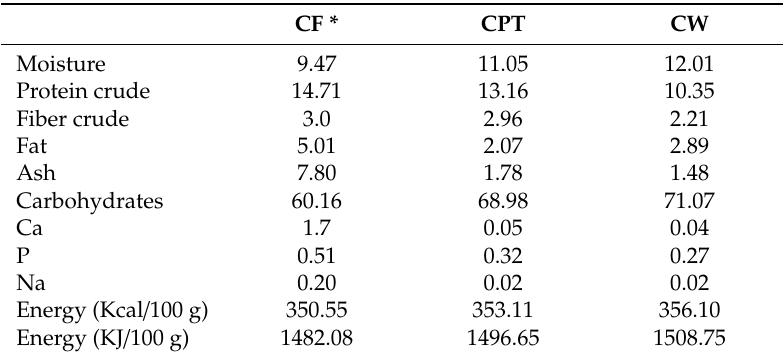
Table 1. Chemical composition (%) of commercial feeding, corn, wheat, pea and triticale of each group (CF, CPT and CW) used in feeding of laying